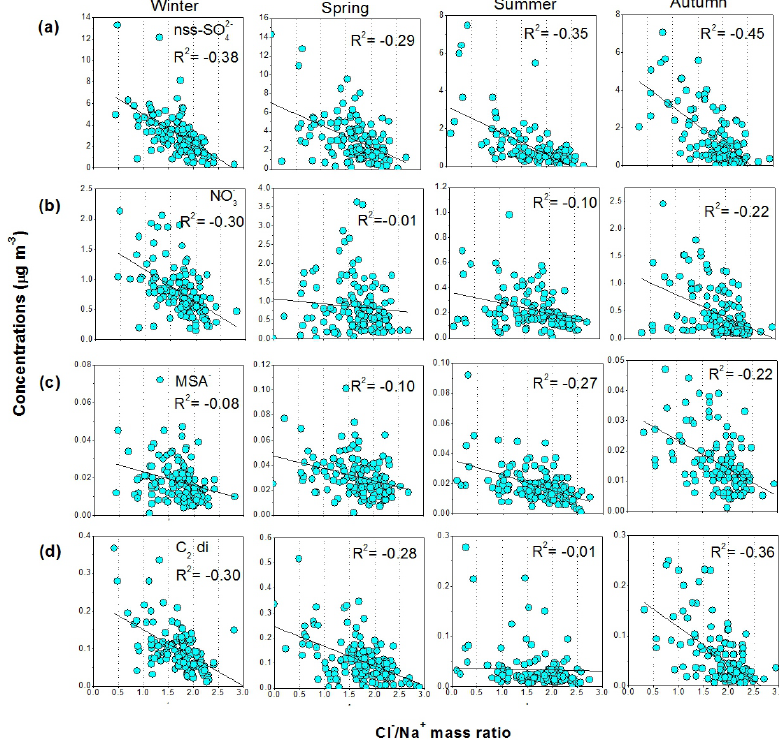
Figure 10. Relations between chloride depletion (Cl − / Na + mass ratio) and acidic species (a) nss-SO 2 − alic acid (C 2 di) for different seasons over the western North